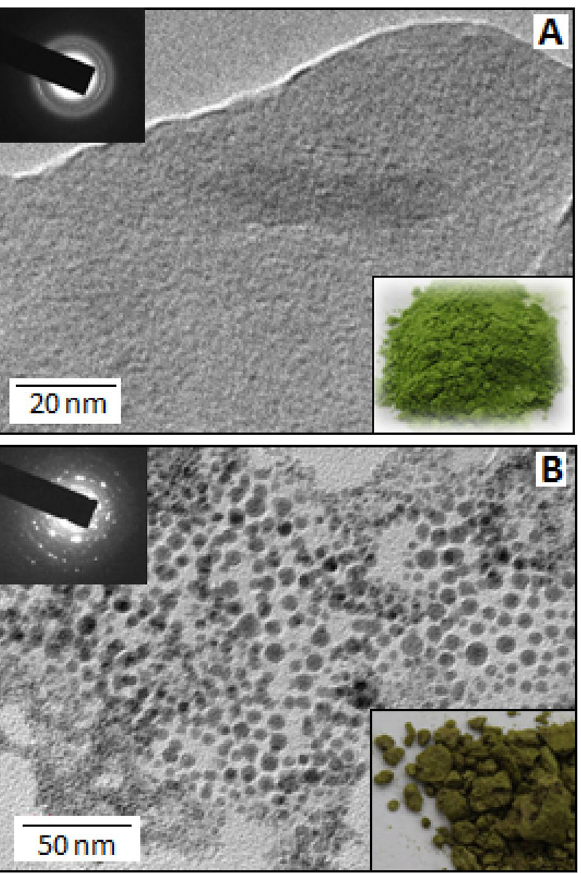
Figure 1. ( A ) TEM image of Cu-polyaniline. Inset: Selected area diffraction and optical images of Cu-polyaniline. ( B ) TEM image of CuN 3 -polyaniline. Inset: Selected area diffraction and optical images of CuN 3